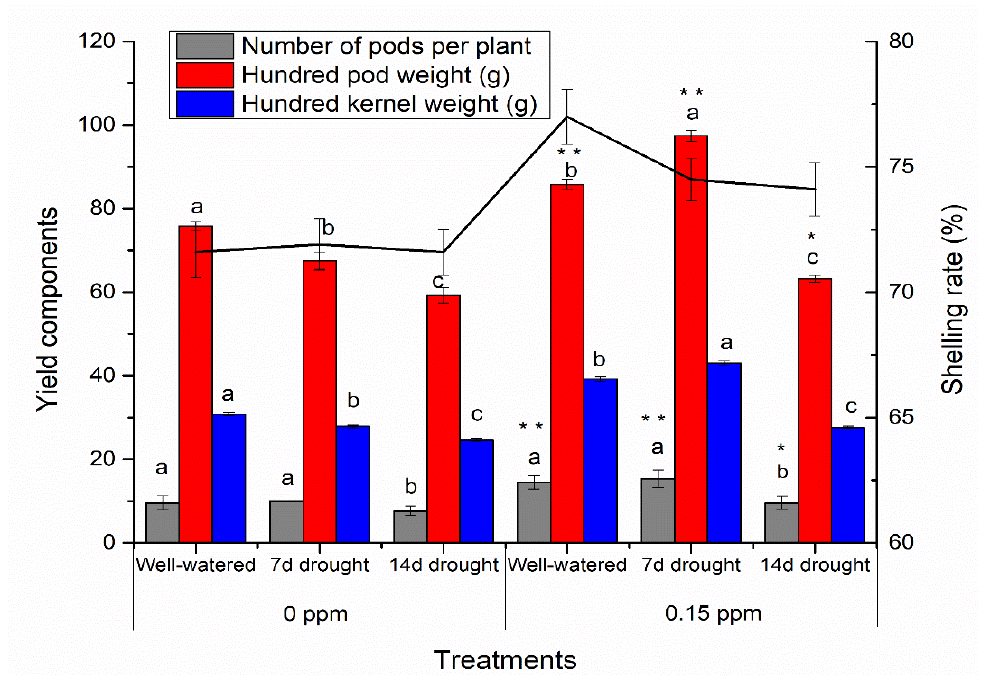
Figure 3. E ff ects of BR priming on peanut yield components under well-watered and drought conditions. Data are presented as the mean ± standard error ( n = 3). Letters represent the statistically significant di ff erence between any two conditions of well-watered, 7-d drought, and 14-d drought ( p < 0.05) as determined by the least significant di ff erence test at the same ppm of concentration. Asterisk * and ** represent the statistically significant di ff erence at p < 0.05 and p < 0.01, respectively, between 0.15 ppm BR priming and 0 ppm BR priming. 7 d, 7 days; 14 d, 14 days.